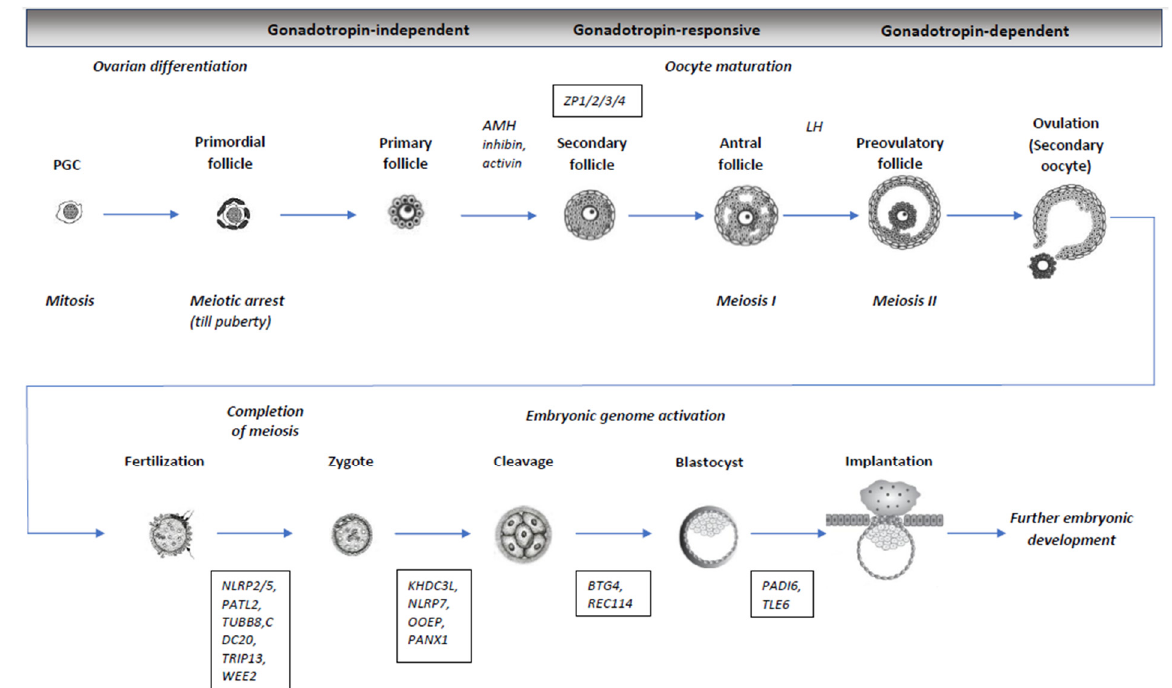
Figure 1. Schematic representation of oogenesis and folliculogenesis in humans, ovulation, fertilization, and early stages of embryonic development with indication of stages, hormones, and some genes involved in their regulation. Gonadotropin-independent, gonadotropin-responsive, and gonadotropin-dependent stages are indicated above. Oocyte maturation period is outlined with a dotted line. PGC, primordial germ cell (gonocyte). The genes are listed in rectangular boxes. AMH—Anti-Müllerian hormone; LH—Luteinizing